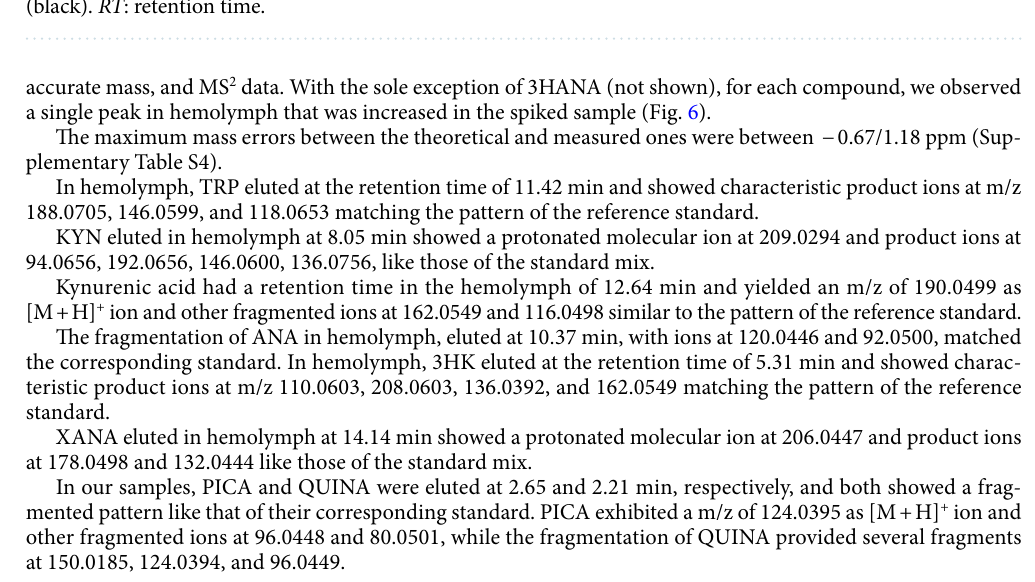
Figure 6. Extracted ion chromatogram of Tryptophan (Trp), kynurenine (KYN), kynurenic acid (KYNA), anthranilic acid (ANA), 3-hydroxy-kynurenine (3HK), xanthurenic acid (XANA), picolinic acid (PICA), and quinolinic acid (QUINA) in hemolymph (red) or hemolymph spiked with a mixture of internal standard (black). RT : retention